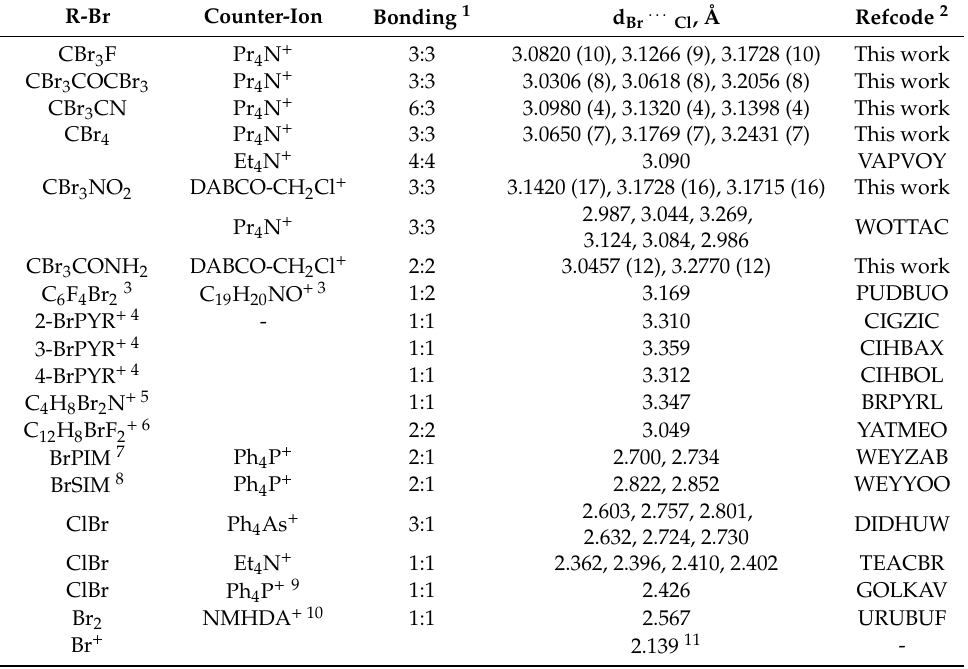
Table 1. Halogen Br ... Cl bond length in the solid-state